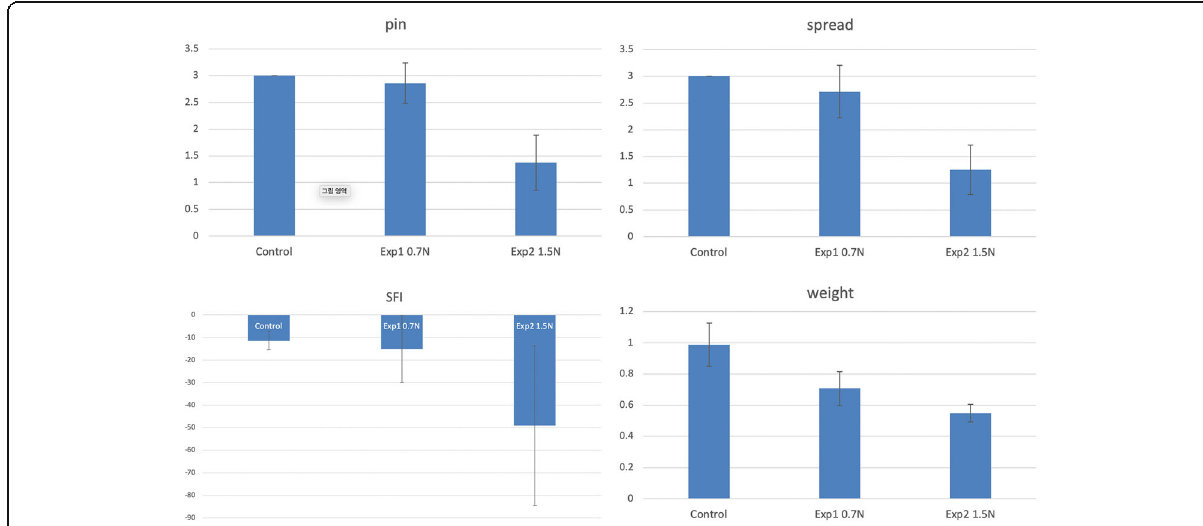
Fig. 4 Results of functional test and muscle weight comparison. ( a pinprick test, b toe spread test, c sciatic function index from walking track analysis, d gastrocnemius muscle weight